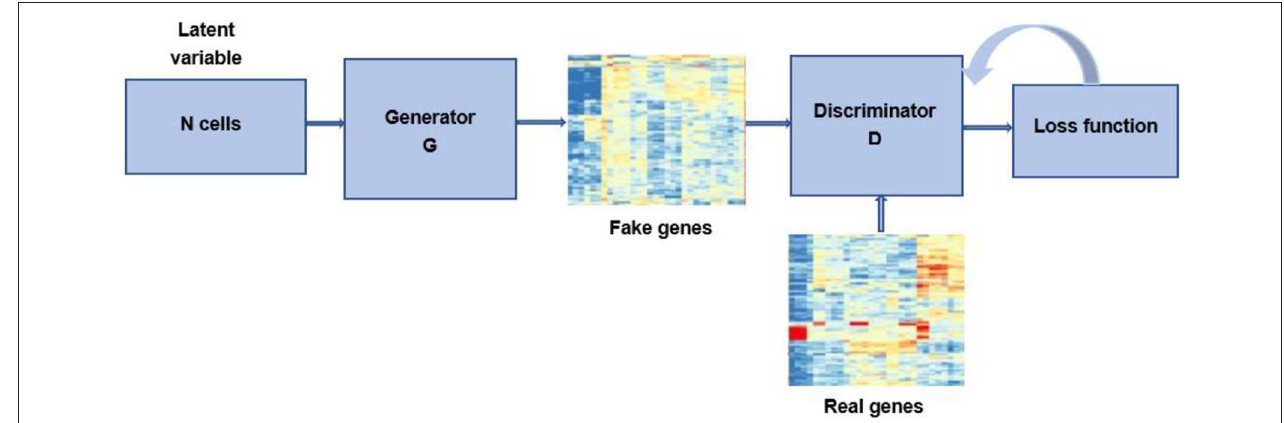
FIGURE 5 | Bioinformatics diagram of